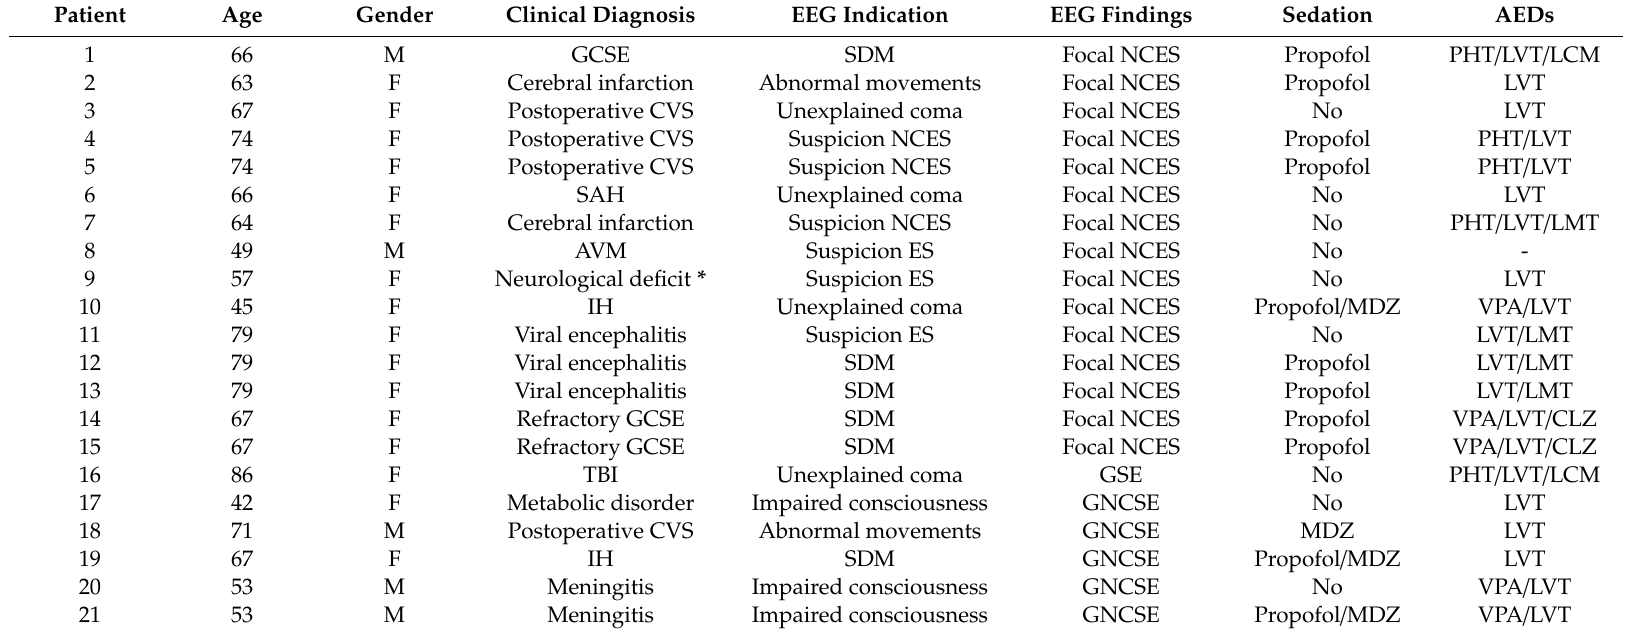
Table 2. Clinical features of patients showing